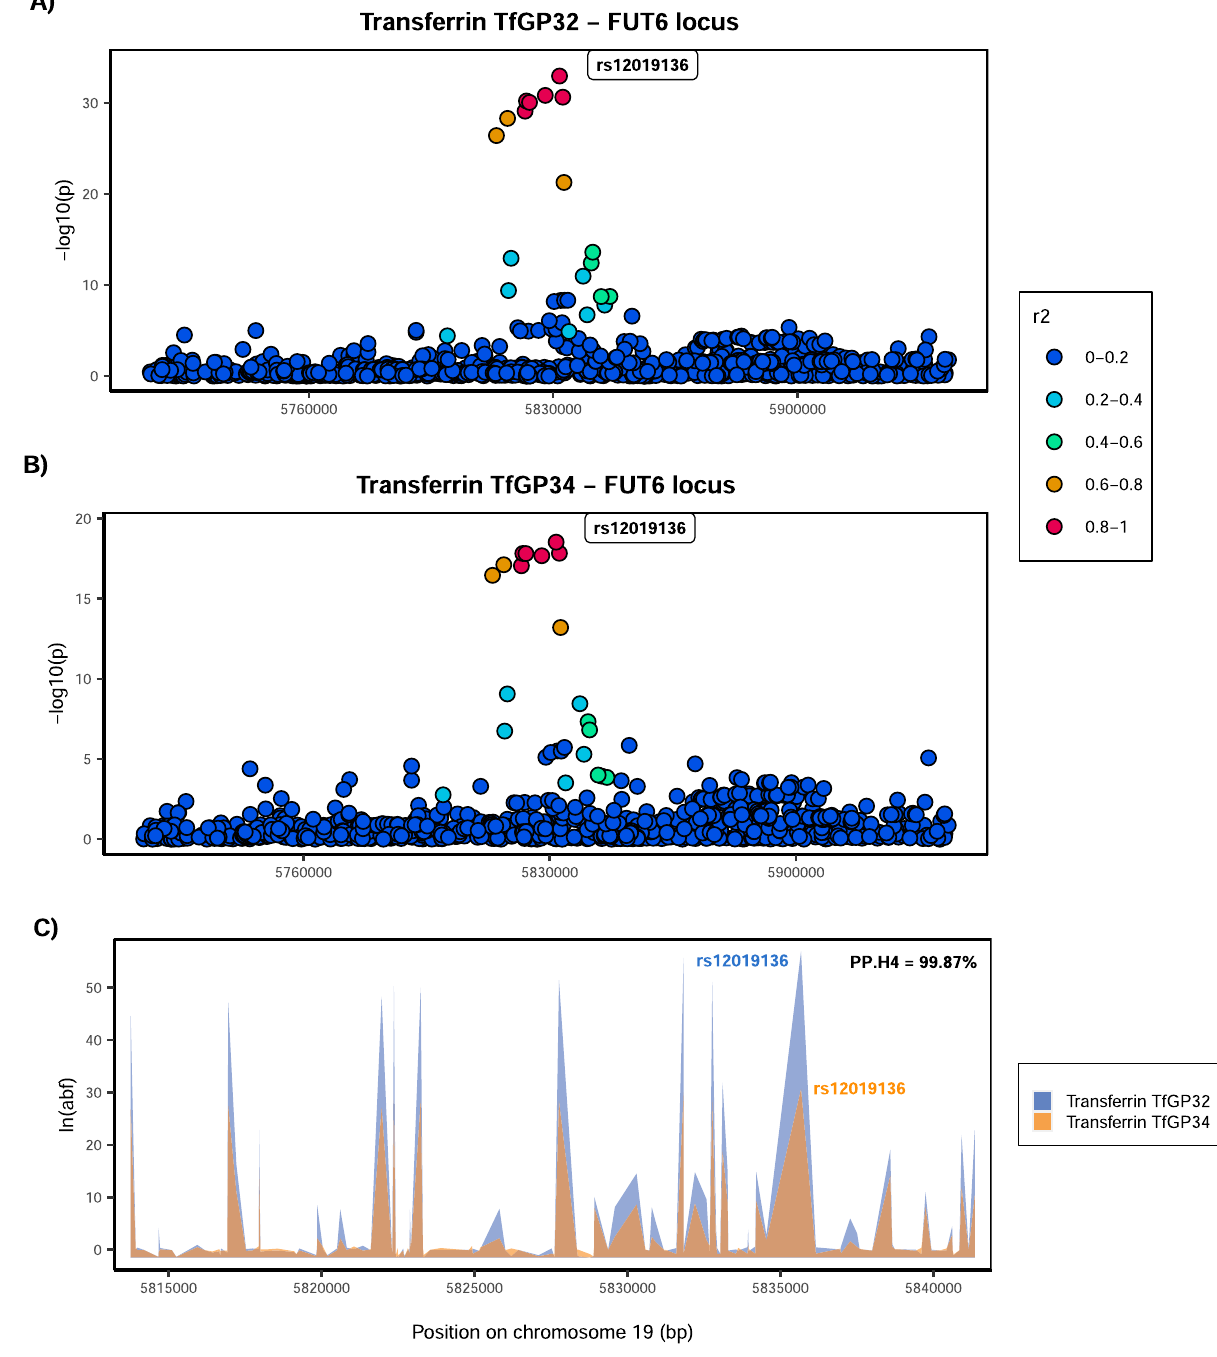
Fig. 2 Colocalisation of two transferrin glycosylation traits in the FUT6 locus (within-protein colocalisation). Local association patterns for transferrin A TfGP32 and B TfGP34 glycans, and C their colocalisation pattern at the FUT6 locus. TfGP32 and TfGP34 association patterns colocalise, with PP.H4 (posterior probability for hypothesis 4, of colocalisation) of 99.87%. The natural logarithm of Approximate Bayes Factor (ABF) of each SNP for transferrin TfGP32 and transferrin TfGP34 in the FUT6 region shows that TfGP32 and TfGP34 associations are concordant (the patterns of ln(ABF) calculated for each SNP of both traits overlap), suggesting that the same underlying causal variant is associated with both traits. SNP most strongly associated in the region with the listed glycan trait is reported in bold and